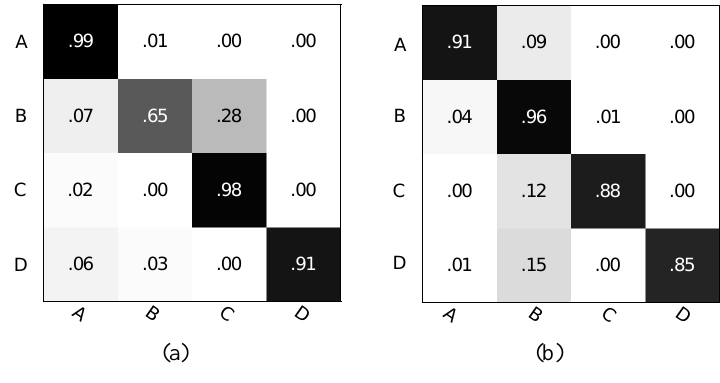
Figure 12. The confusion matrix for the intersection dataset. ( a ) Causal grouping; ( b ) K-means clustering.